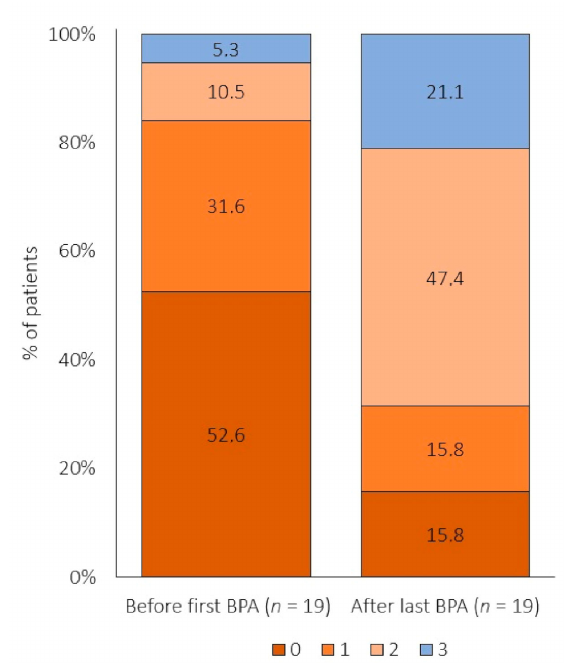
Figure 4. Risk profile assessed by the presence of three noninvasive variables (NYHA functional class, 6MWD and NTproBNP) before the first and after the last BPA session. Abbreviations: BPA—balloon pulmonary angioplasty; n —number; NYHA—New York Heart Association; 6MWD—6-min walking distance; and NTproBNP—N-terminal pro-brain natriuretic